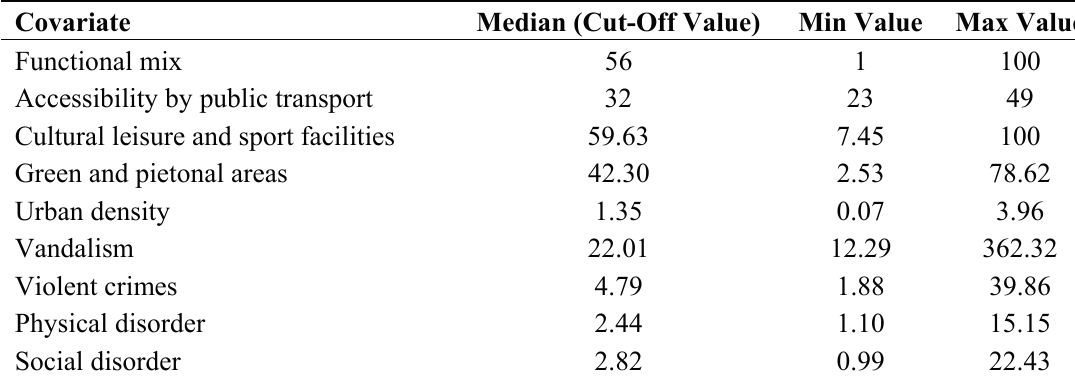
Table 1. Cut-off